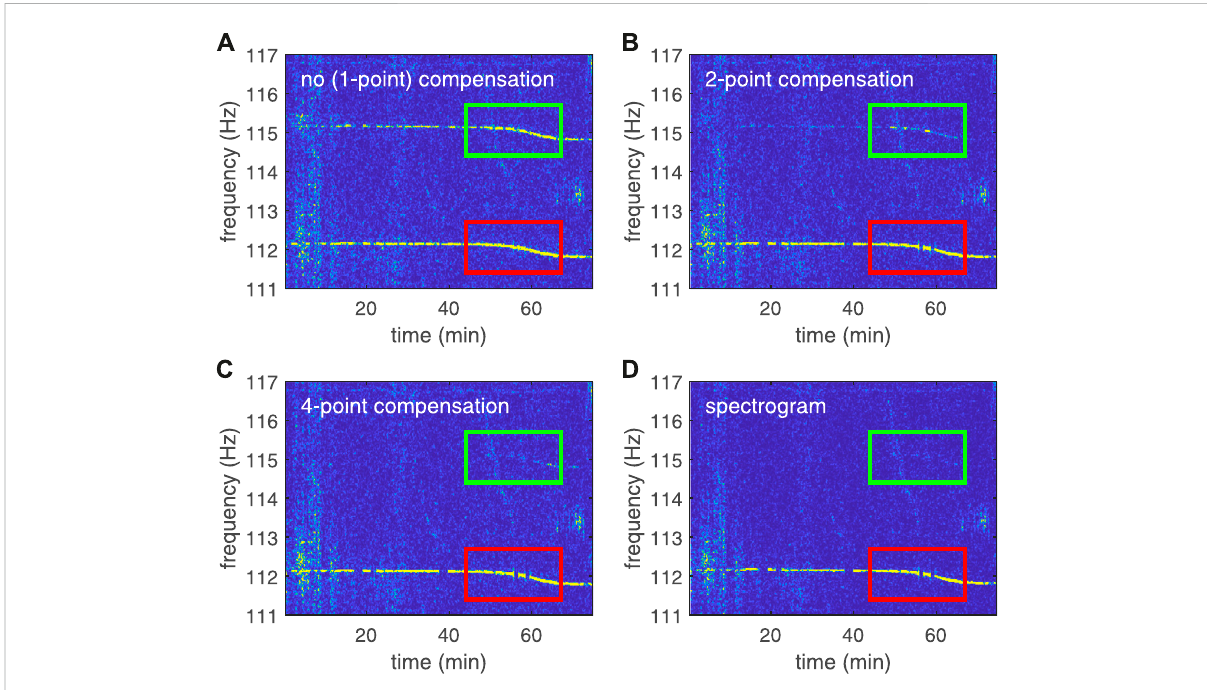
FIGURE 2 The SWellEx-96 signal used in Section 4 is employed to illustrate the phenomenon of power spectrum error. (A – C) illustrate, respectively, the TFDs produced by Eq. 9 (i.e., the step R2.4 of F-STFT) with different compensations, where thelength of the spectral window N w 1 = 500. The aliased IF trajectories has been mapped into the real frequency band by a contrary procedure of aliasing. (D) Shows the TFD produced by STFT. The green rectangles show the changes of an aliased IF trajectory with the increase of compensation points, and the red rectangles show the changes of the target IF trajectory with the increase of compensation points. It can be seen that a few compensation points are able to give a good approximation for the spectrogram if the phenomenon of power spectrum error